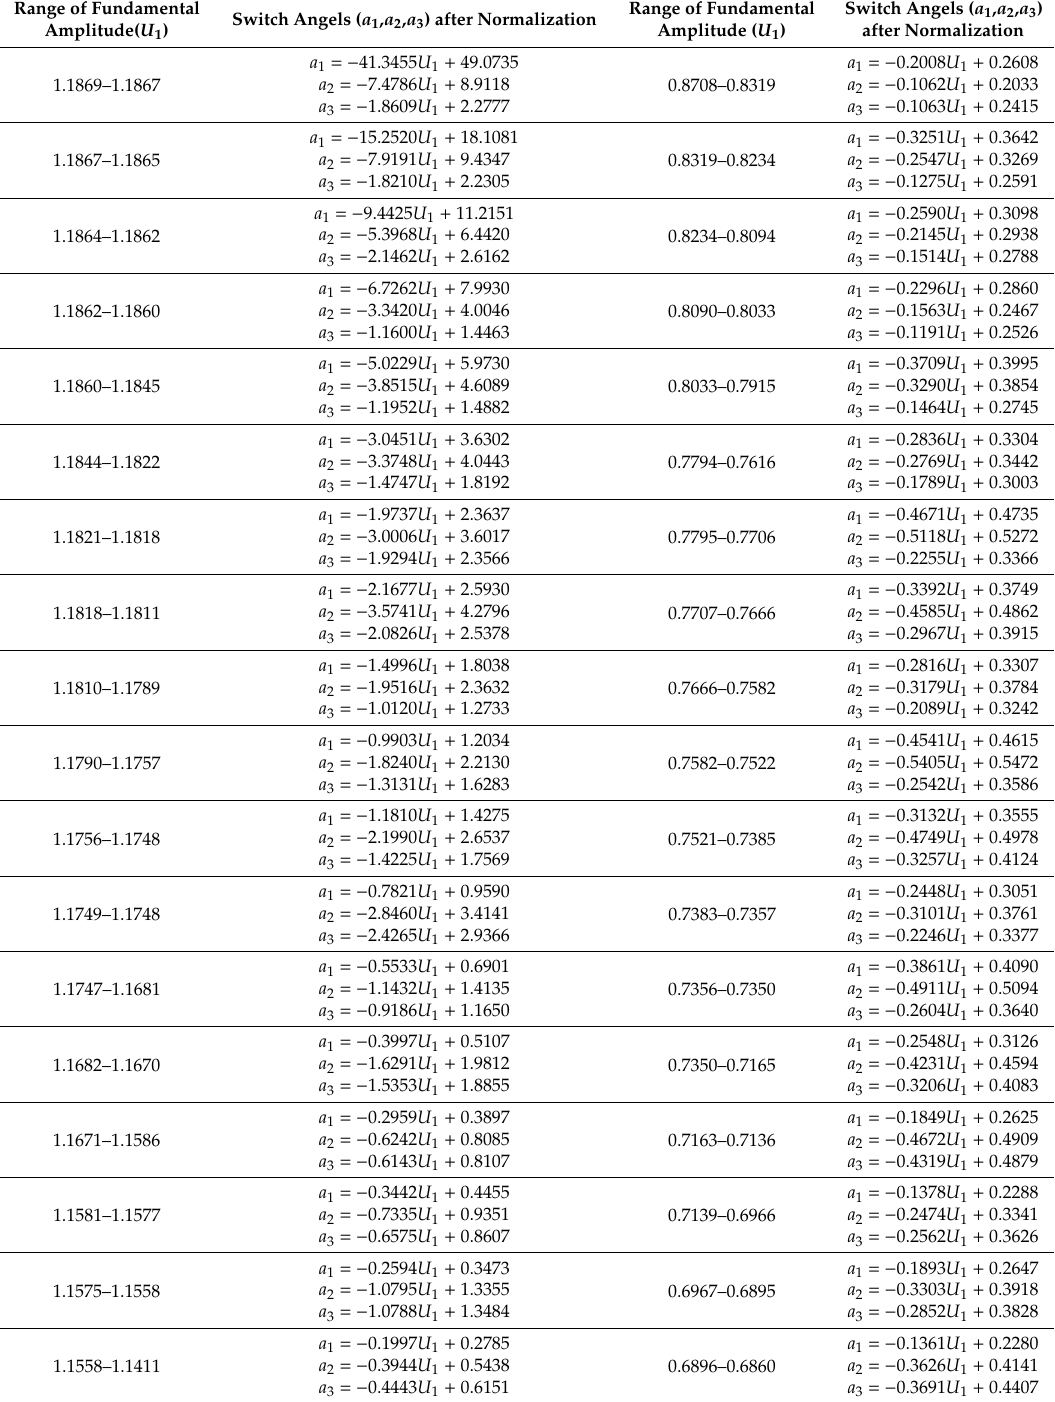
Table 7. Results of C waveband switching angles when N =